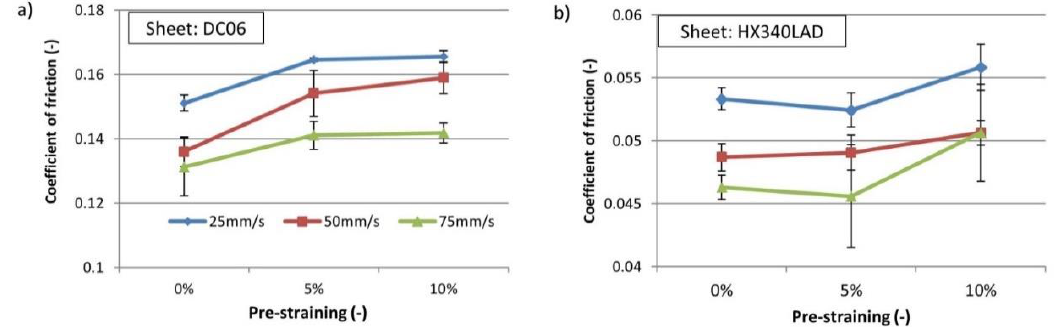
Figure 11. Coefficient of friction with variation of sliding velocity and pre-straining by contact stress of 2.5 MPa; ( a ) material DC06 with electrolyte galvanized coating; ( b ) material HX340LAD with galvanized coating.